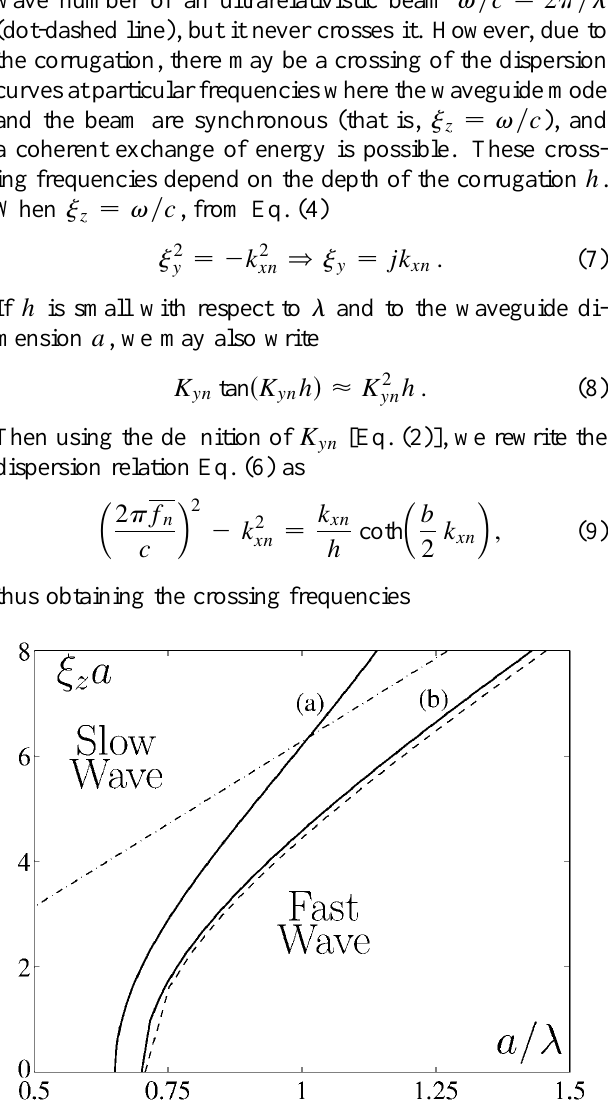
FIG. 3. Dispersion diagram for a square waveguide of side a with corrugation on two opposite sides. The solid lines are obtained from Eq. (6): line (a) is for h (cid:3) a (cid:1) 0.1 , while line (b) is for h (cid:3) a (cid:1) 0.01 . The dashed line corresponds to the unperturbed TM 11 mode of the smooth waveguide and the dot-dashed line represents an ultrarelativistic